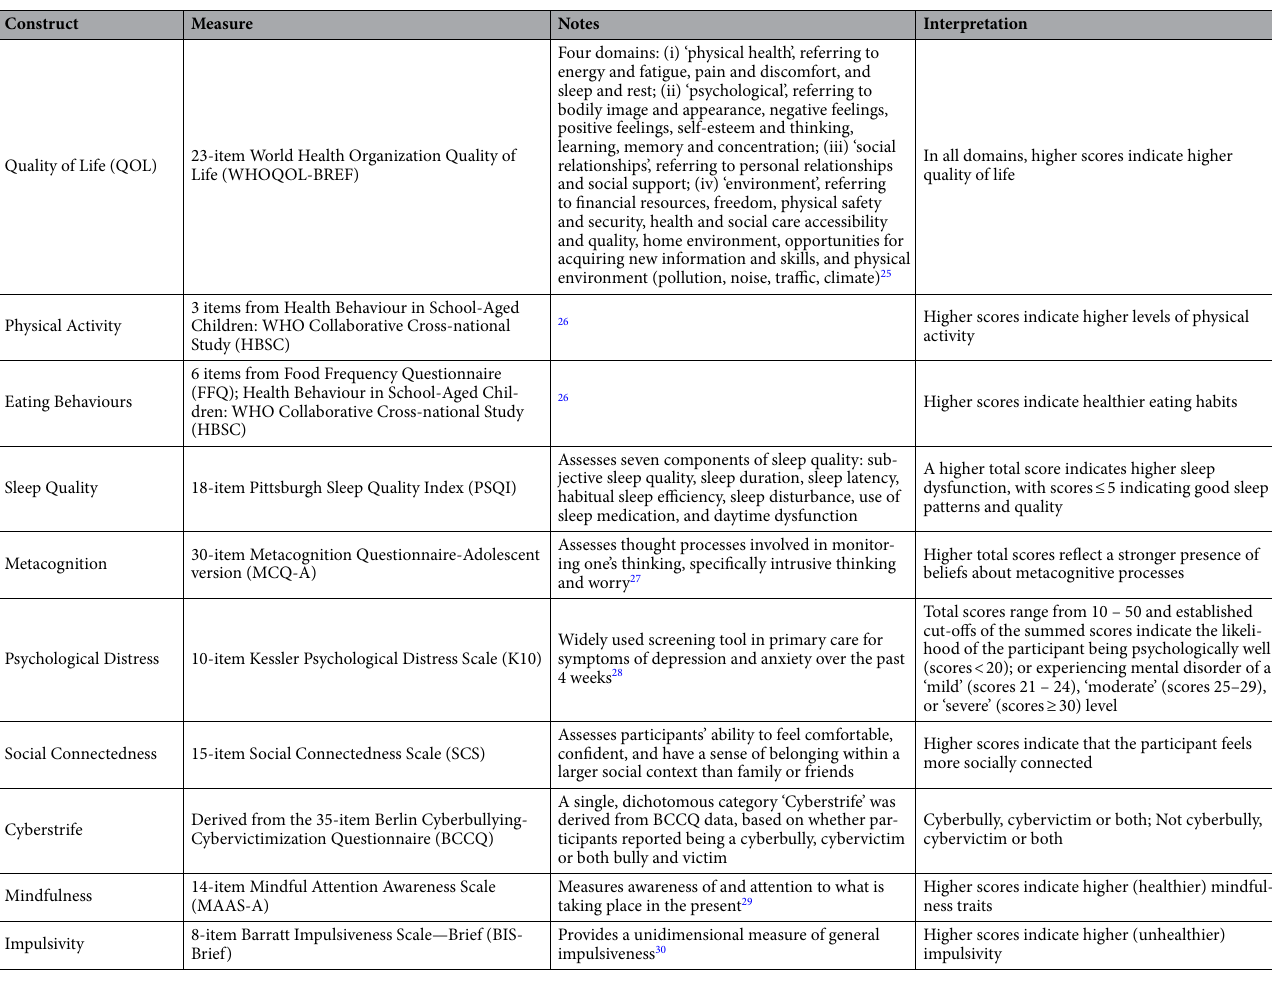
Table 1. LABS variables used to model risk of psychological